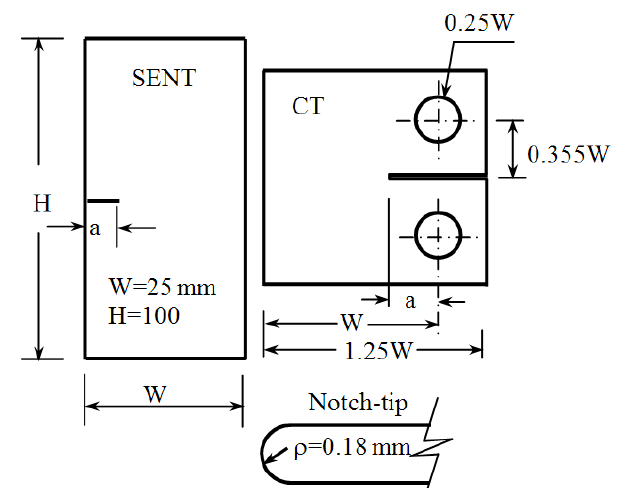
Figure 1: Configurations of SENT and CT specimens used for plastic zone